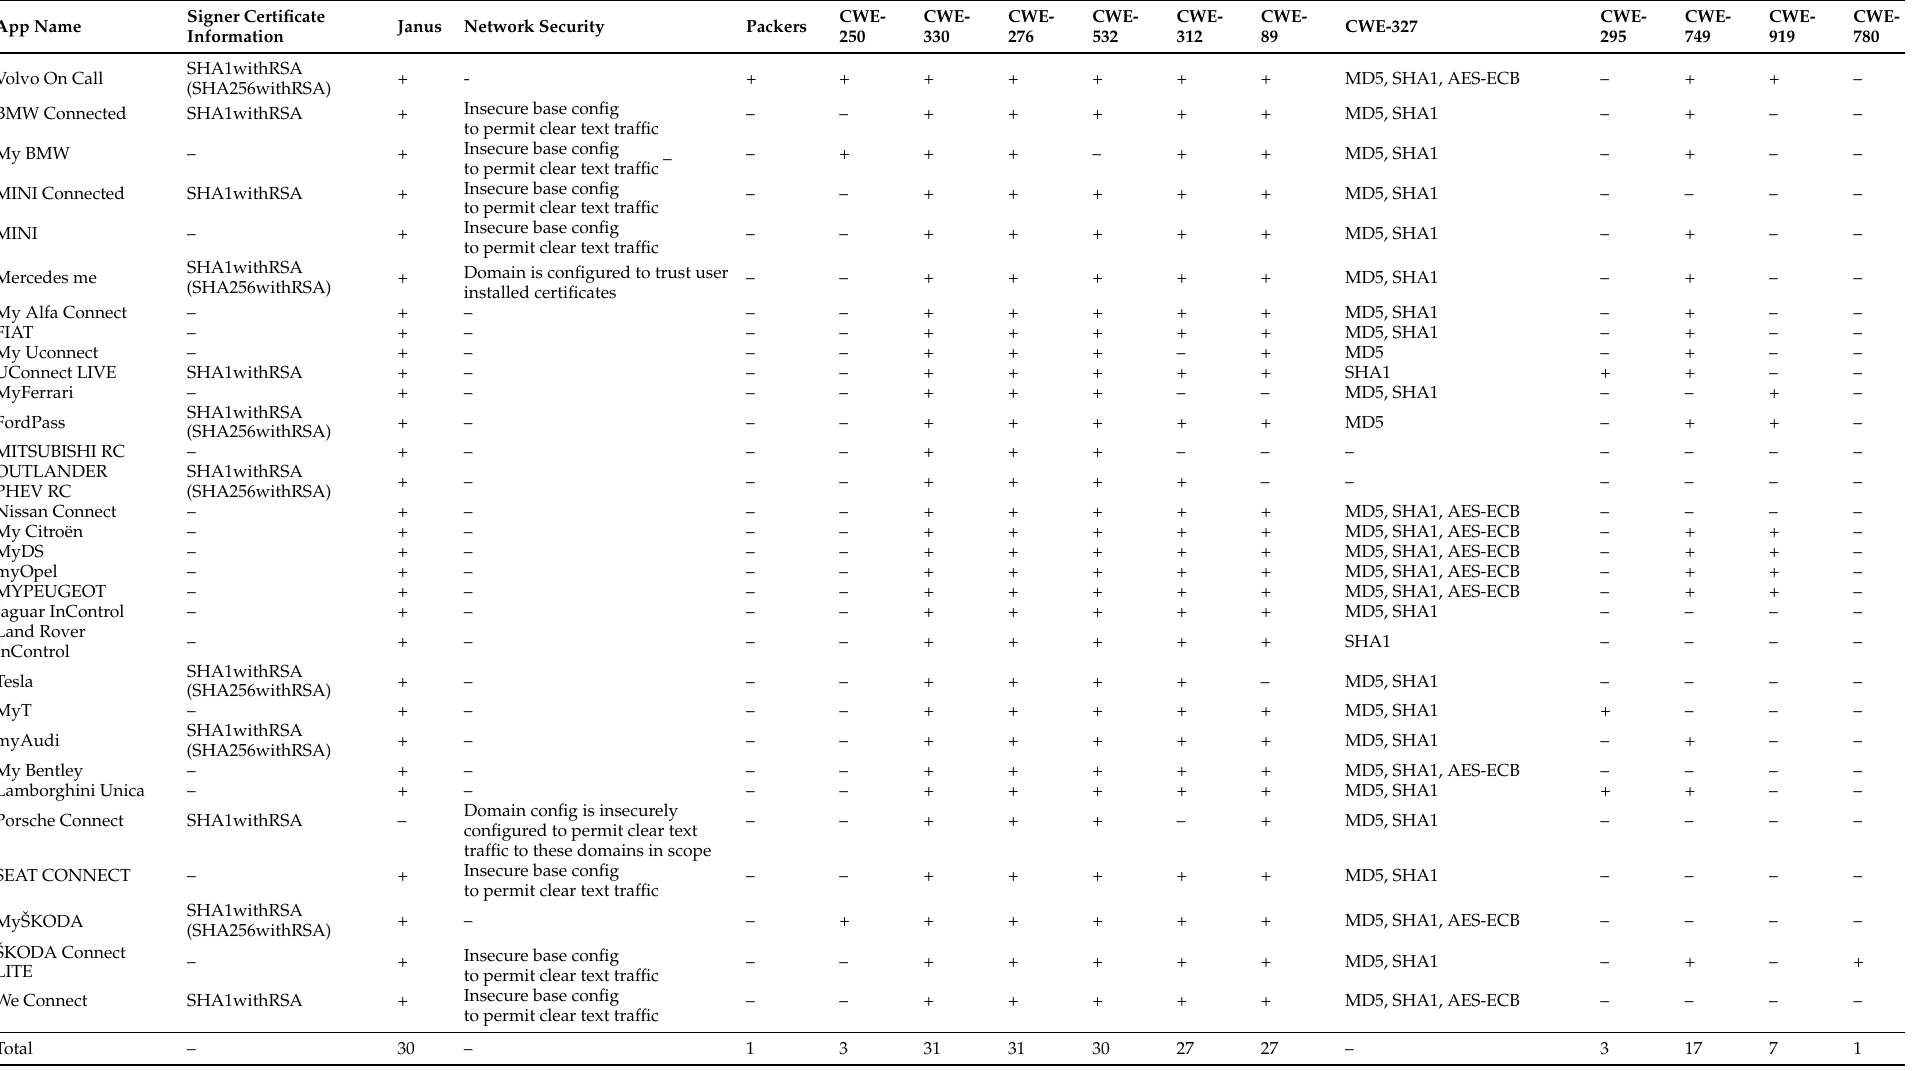
Table 5. Potential weaknesses and other security issues per